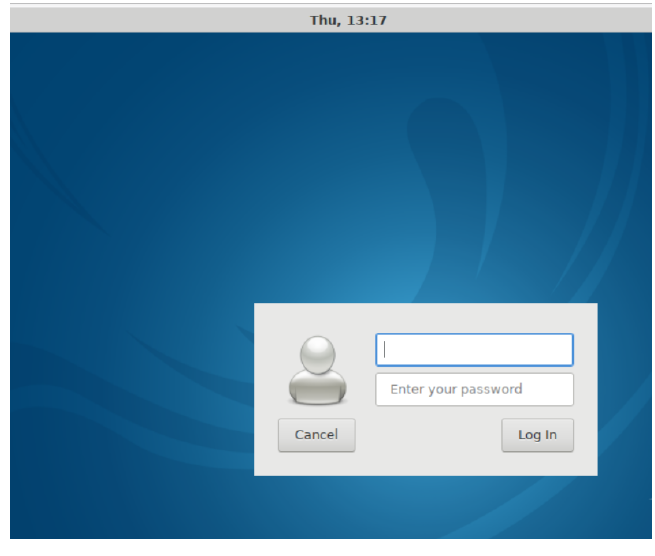
Figure 3. Accessing to a Network Node of the Laboratory for the CIS Subject.